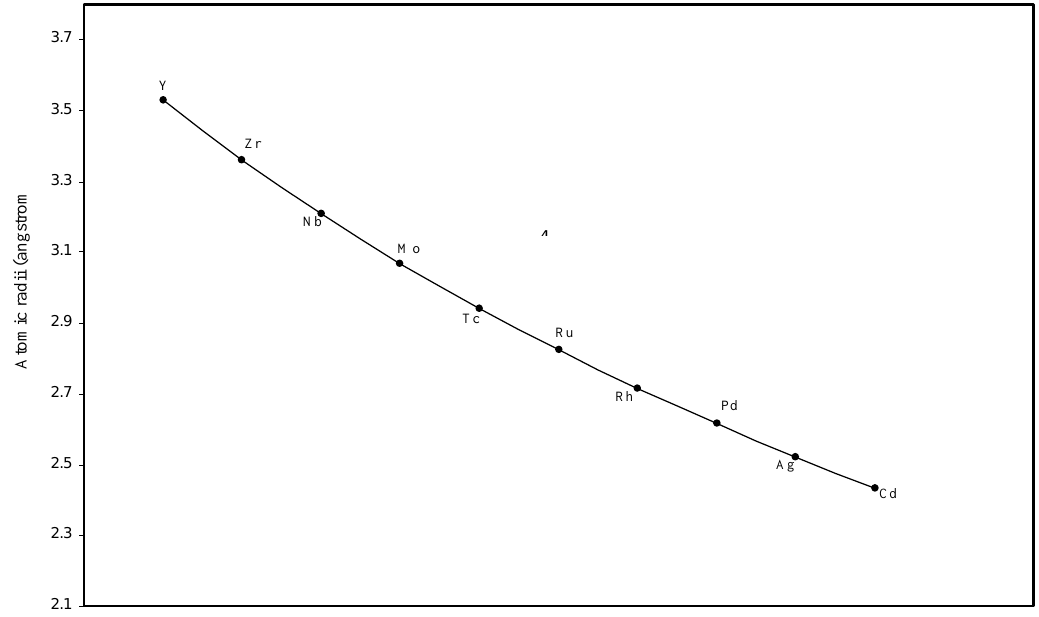
Figure 4. Plot of atomic radii of second transition series (4-d block) elements in angstrom unit as a function of atomic